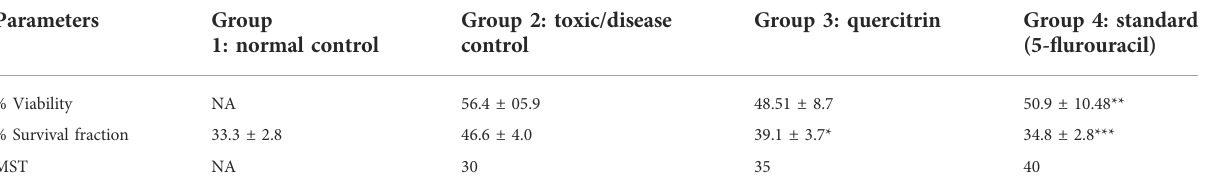
Group 3: quercitrin Group 4: standard